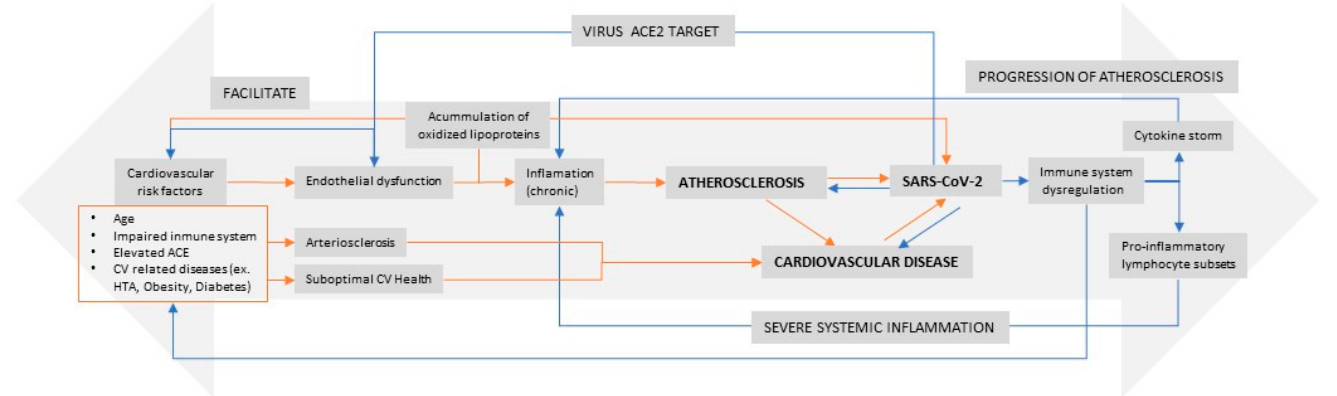
Figure 1. Bidirectional association between atherosclerosis and SARS-CoV2 infection (adapted from Vinciguerra et al. [27]).